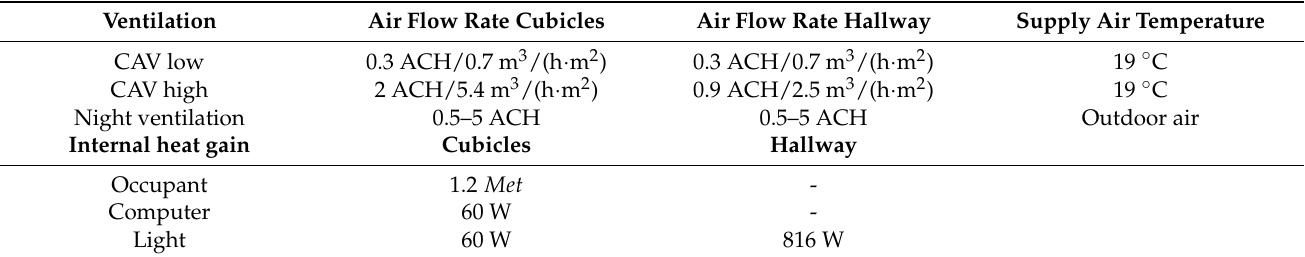
Table 5. Ventilation parameters and internal heat